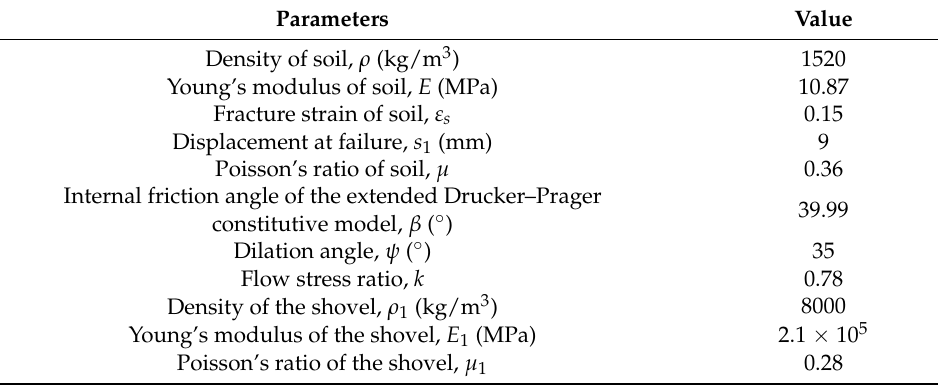
Table 1. Parameters used in the FE